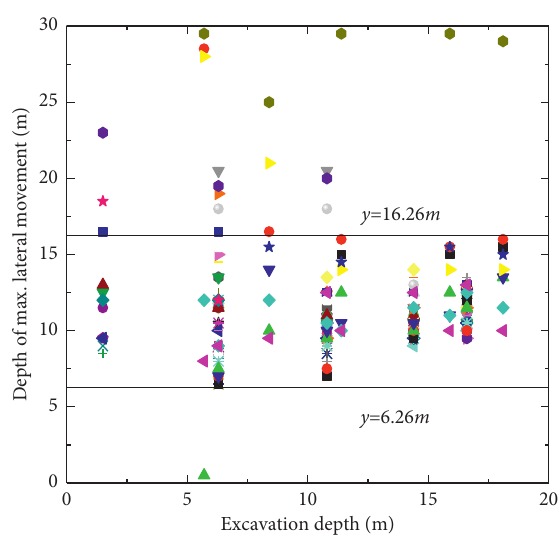
Figure 11: Relationship between the depth of the maximum lateral movement and excavation depth.